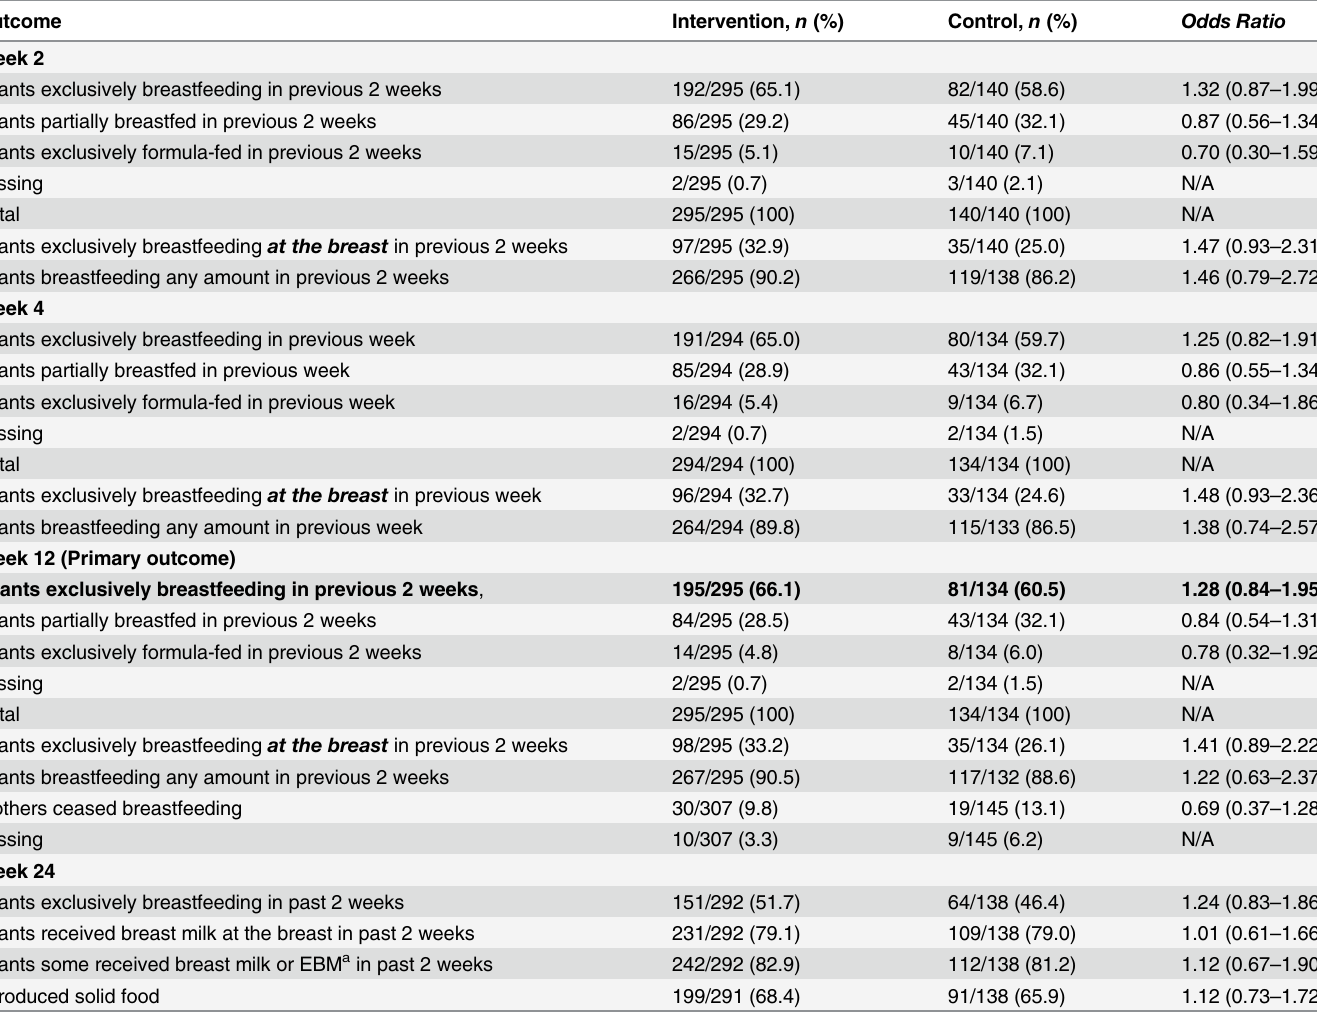
Table 4. Breastfeeding outcomes at 2, 4, 12 and 24 weeks postpartum.